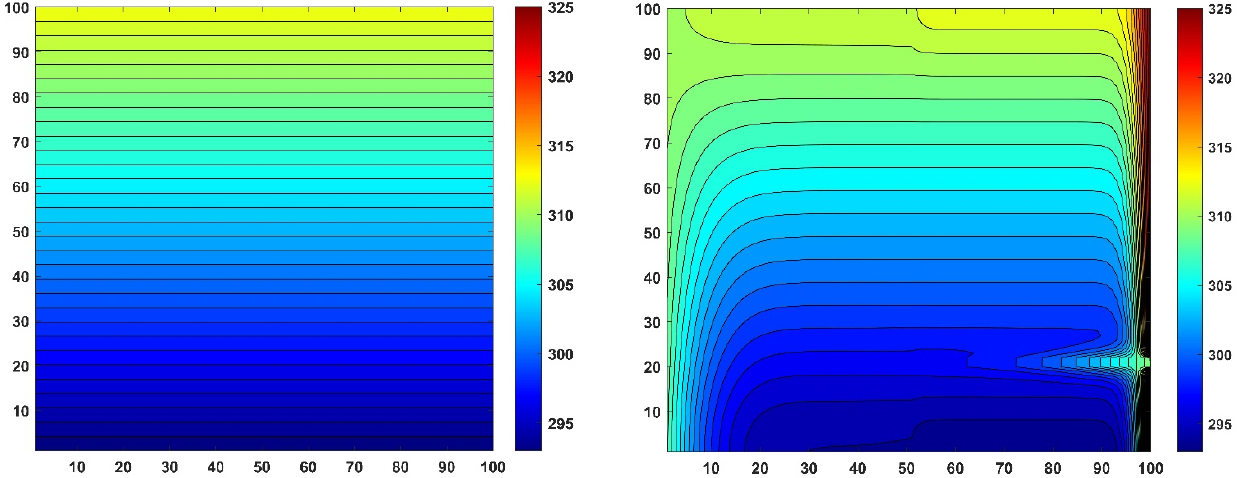
Figure 16. The temperature distribution contour in Kelvin units at the initial (left) and the final time (right) in the case of Experiment 7 (equidistant mesh).